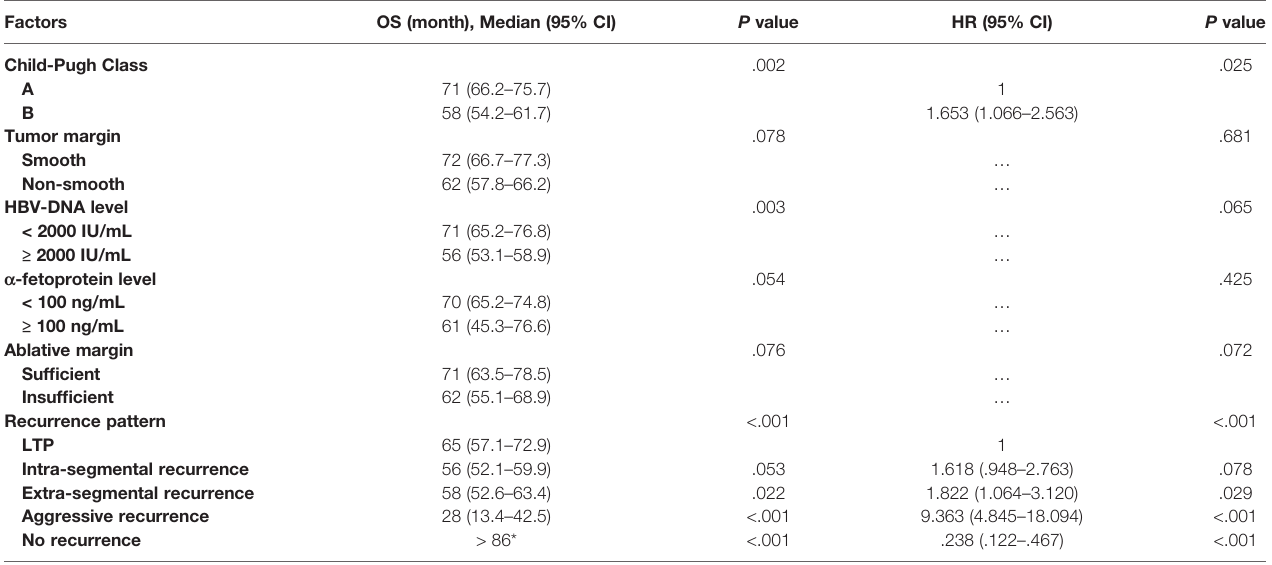
TABLE 5 | Univariate and multivariate analysis of the prognostic factors for overall survival in the entire study population (N = 249). Factors OS (month), Median (95% CI) P value HR (95% CI) P value Child-Pugh Class